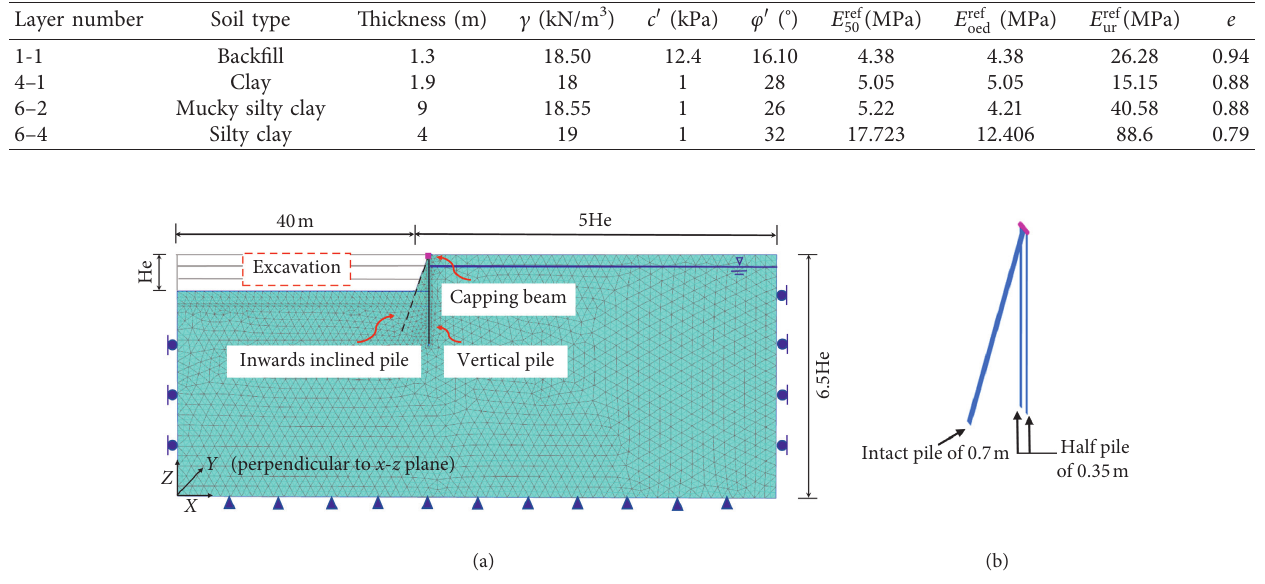
Figure 3: An excavation retained by VIIP. (a) Finite element mesh; (b) 3D view of VIIP. Table 2: Parameters of structures in finite element